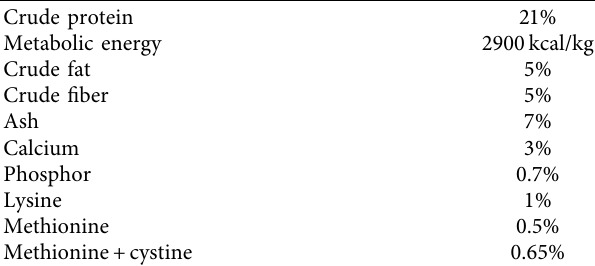
Table 1: Chemical composition and energy of the quail diet.